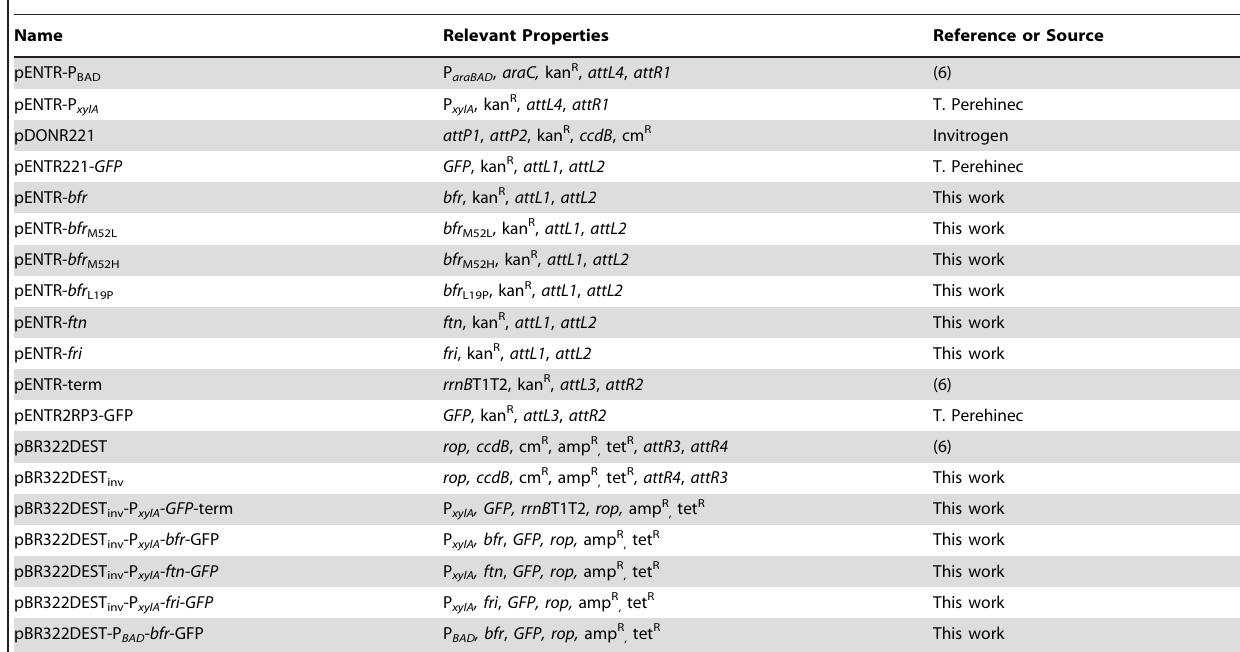
Table 1. Plasmids used in this